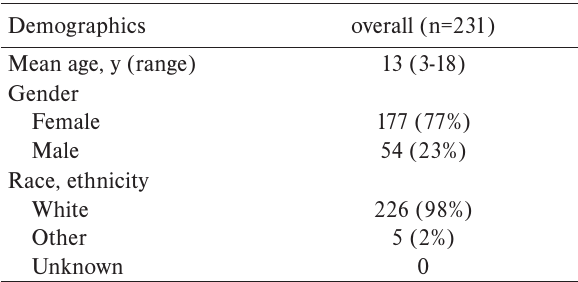
Table 1. Demographic characteristics of patients with AIT at the time of